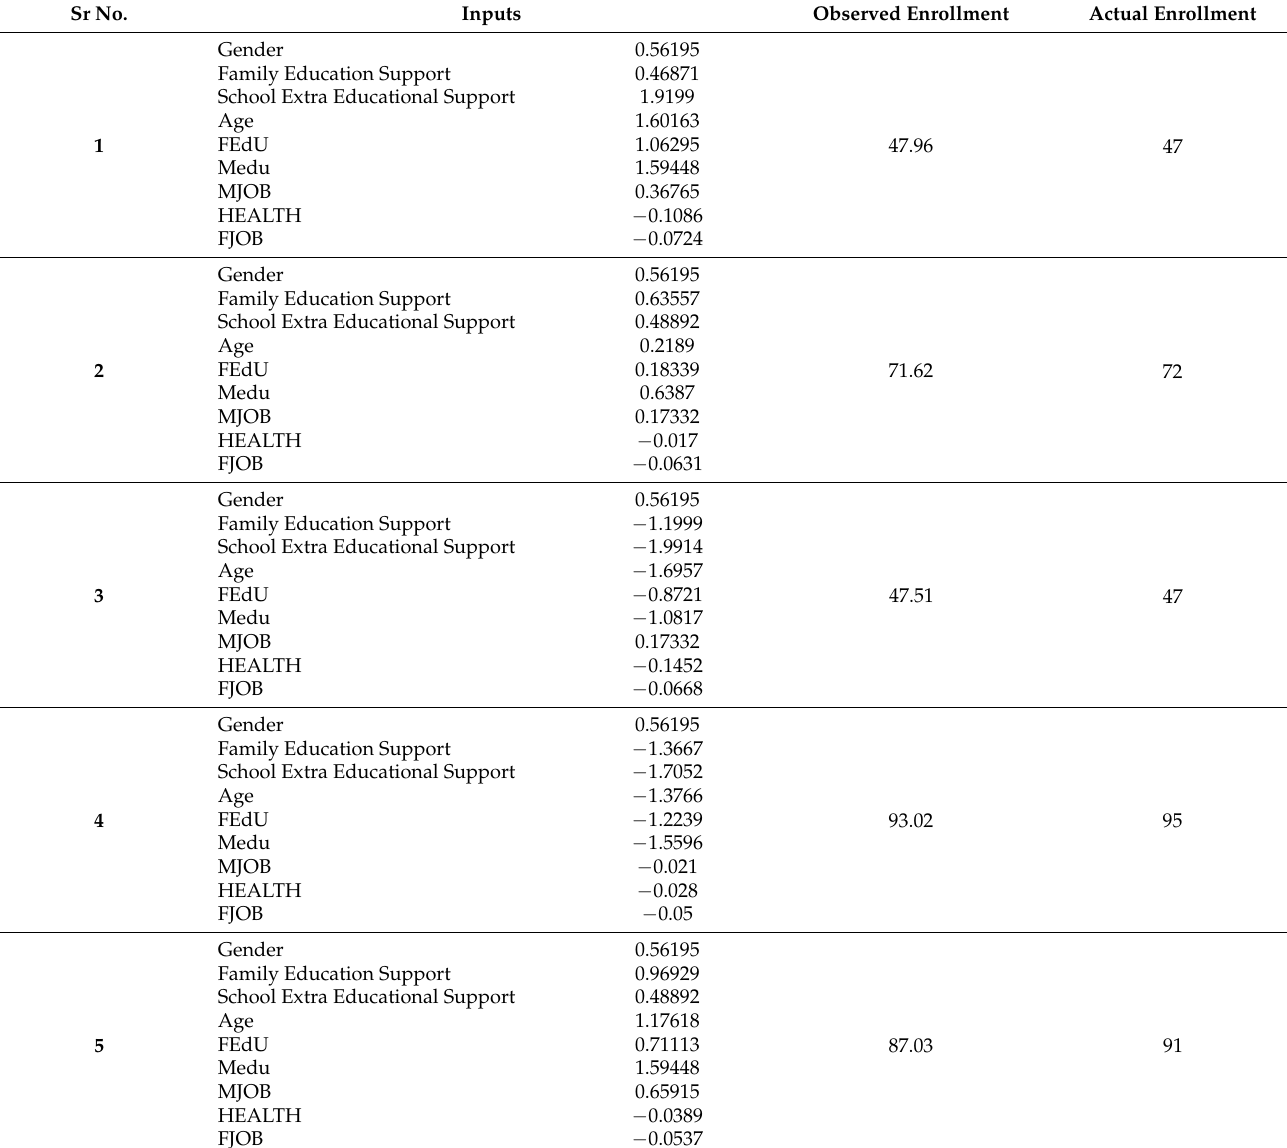
Table 11. Final testing